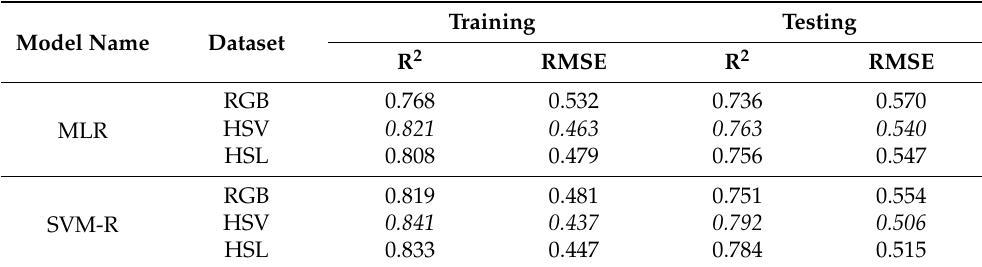
Table 5. Performance metrics (R 2 and RMSE) of the models for predicting TSS of strawberry fruits during the testing and training period. The values in italics indicate the best results in each model among the three colour spaces.